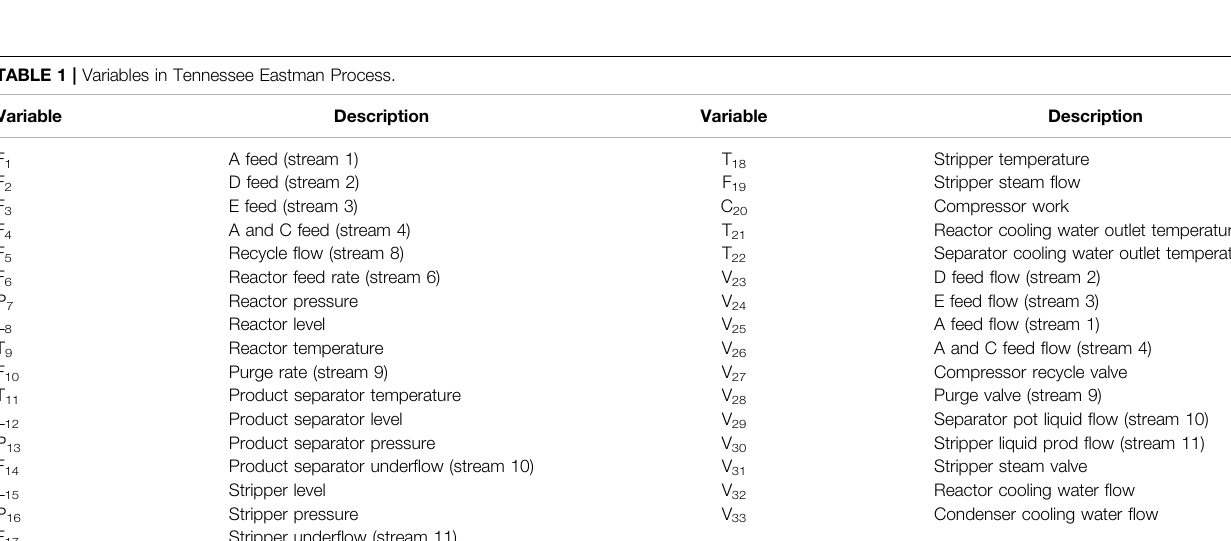
FIGURE 3 | The fl ow chart of Tennessee Eastman Process (Bathelt et al., 2015).